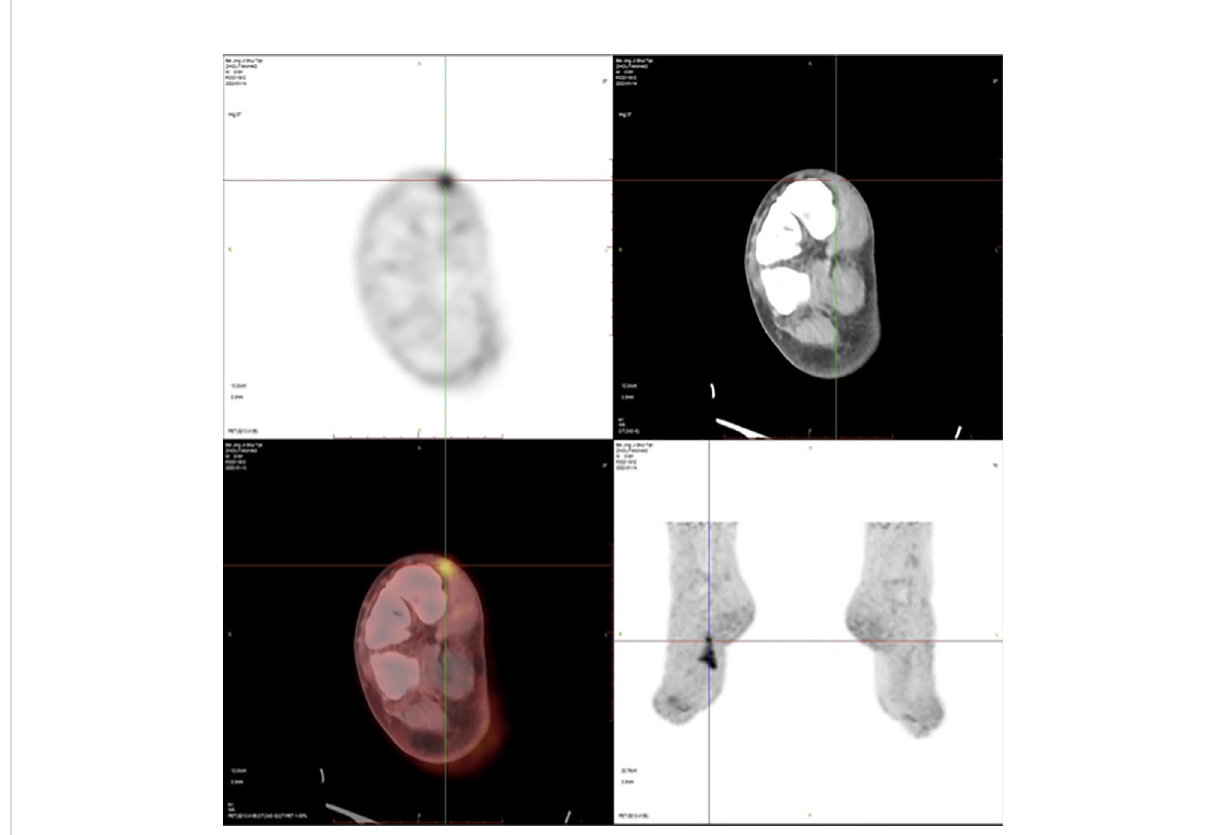
FIGURE 2 Positron emission tomography/computed tomography (PET/CT) imaging after unplanned resection of DFSP showed an increased radioactive uptake (SUVmax = 5.2) of soft tissue density as well as small nodules in the local subcutaneous soft tissue and have increased metabolic activity.